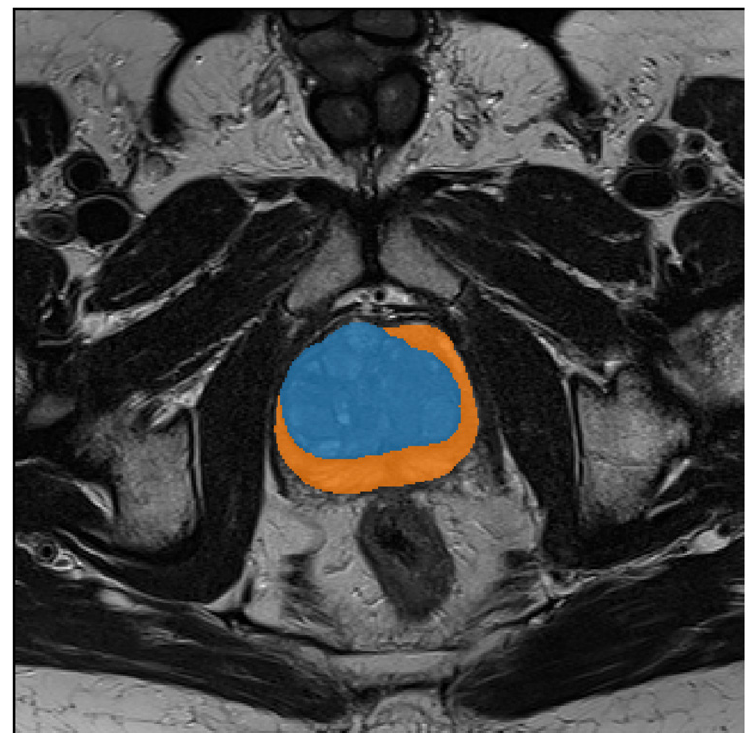
Figure 2. Visualization of the manual annotations prepared for each prostate MRI scan. The inner regions are depicted in blue, while orange shows the outer prostate region.